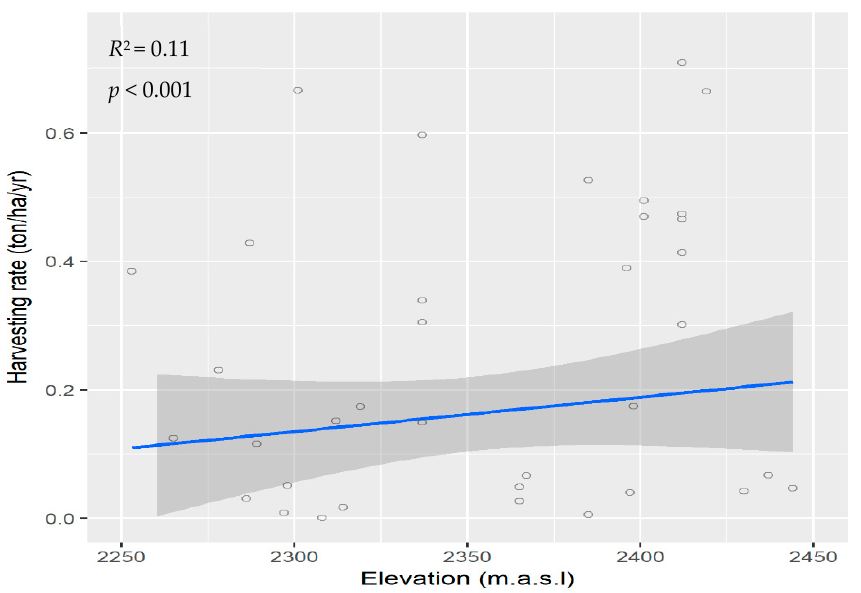
Figure 3. The relationship between harvesting rate of Olea europaea (Wall. ex G. Don) Cif. and elevation in Hugumburda dry. Afromontane forest in northern Ethiopia. The solid lines indicate the fitted lines and the shaded polygons denote the 95% confidence intervals. The grey circles show observed values.